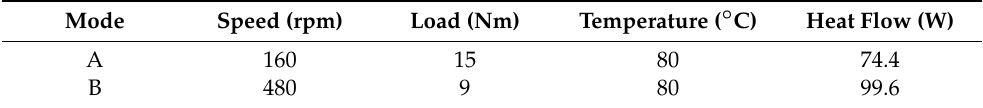
Table 4. The parameters of mode A and mode B.